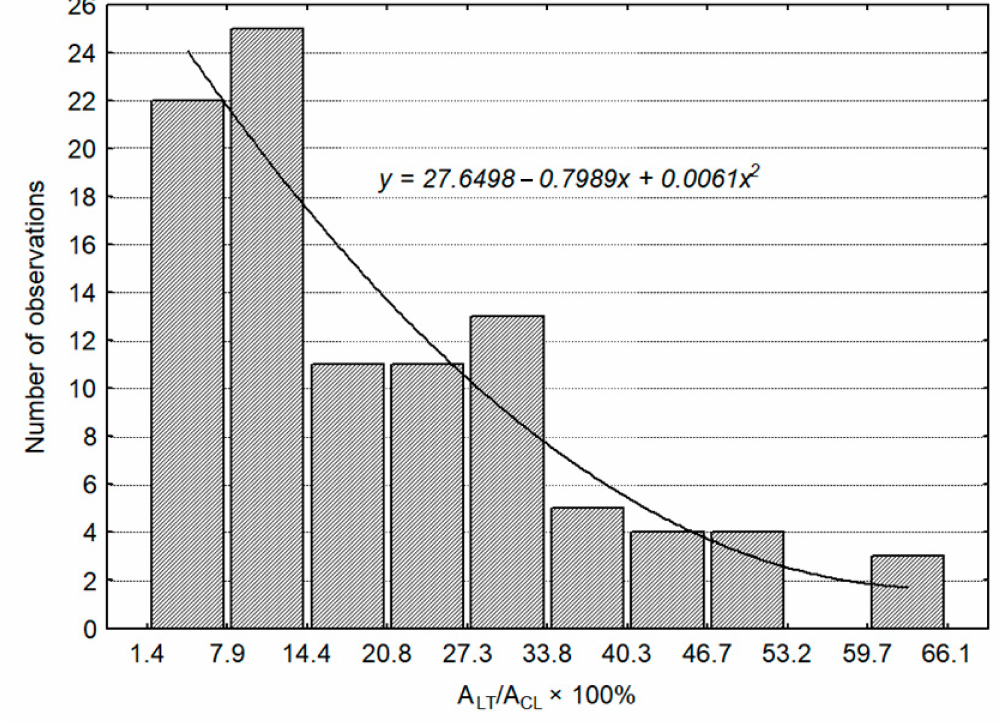
Figure 4. Variation in the range of luteal tissue losses in cavitary CL (in %) n = 98. A LT : area of luteal tissue; A CL : area of cavitary CL; CL: corpus